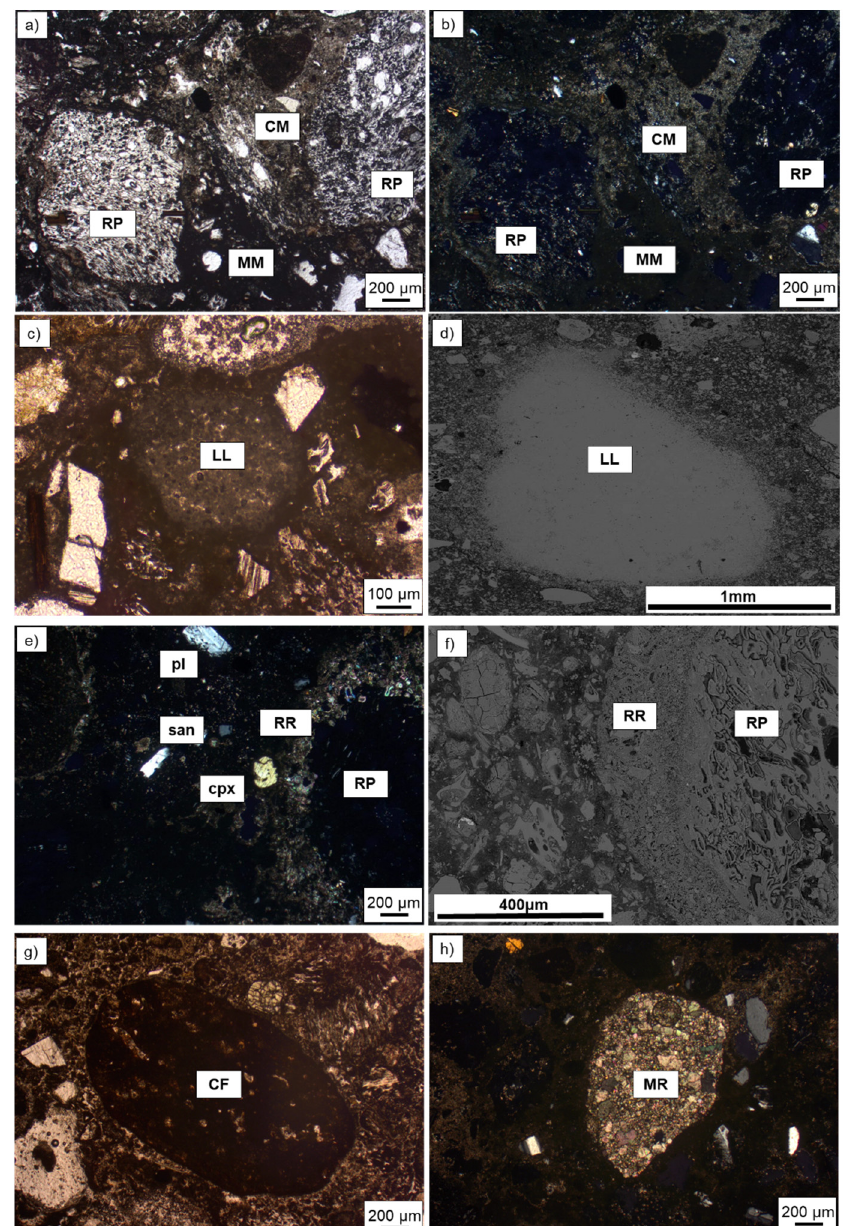
Figure 3. ( a ) Plane polarized and ( b ) crossed polarized light microphotographs showing cryptocrys- talline (CM) and micritic (MM) matrix types and recarbonated pumice (RR) in the P18-1 sample; ( c ) crossed polarized light microphotographs of sample P8-1 showing a lime lump (LL); ( d ) BSE micrograph of sample P65-1 showing a lime lump (LL); ( e ) crossed polarized light microphotographs showing recarbonated pumice (RR) with reaction rim (RR), plagioclase (pl), sanidine (san) and clinopyroxene (cpx) in the P15-1 sample; ( f ) BSE micrograph showing a recarbonated pumice (RP) with reaction rim (RR) in sample P15-1; ( g ) ceramic fragment (CF) in sample P15-1; ( h ) marble relict (MR) in sample P8-1.